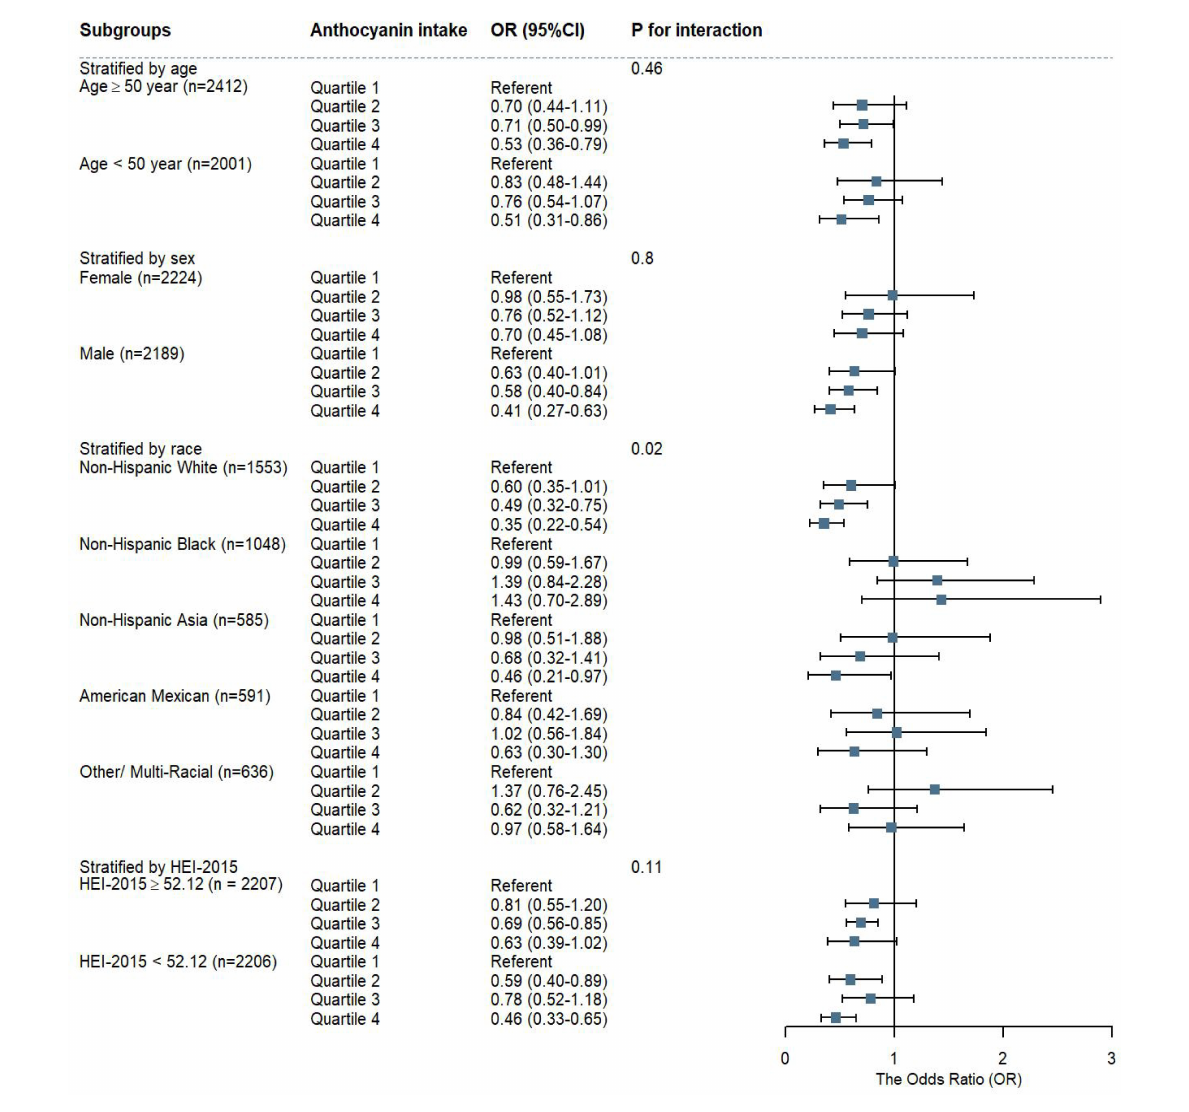
FIGURE4 The weighted stratified and interaction analysis of association between anthocyanidin intake and covariates. The results were adjusted for covariates of age group, sex, race, educational level, PIR, smoking status, alcohol drinking status, energy intake, HEI-2015 scores, except for the corresponding